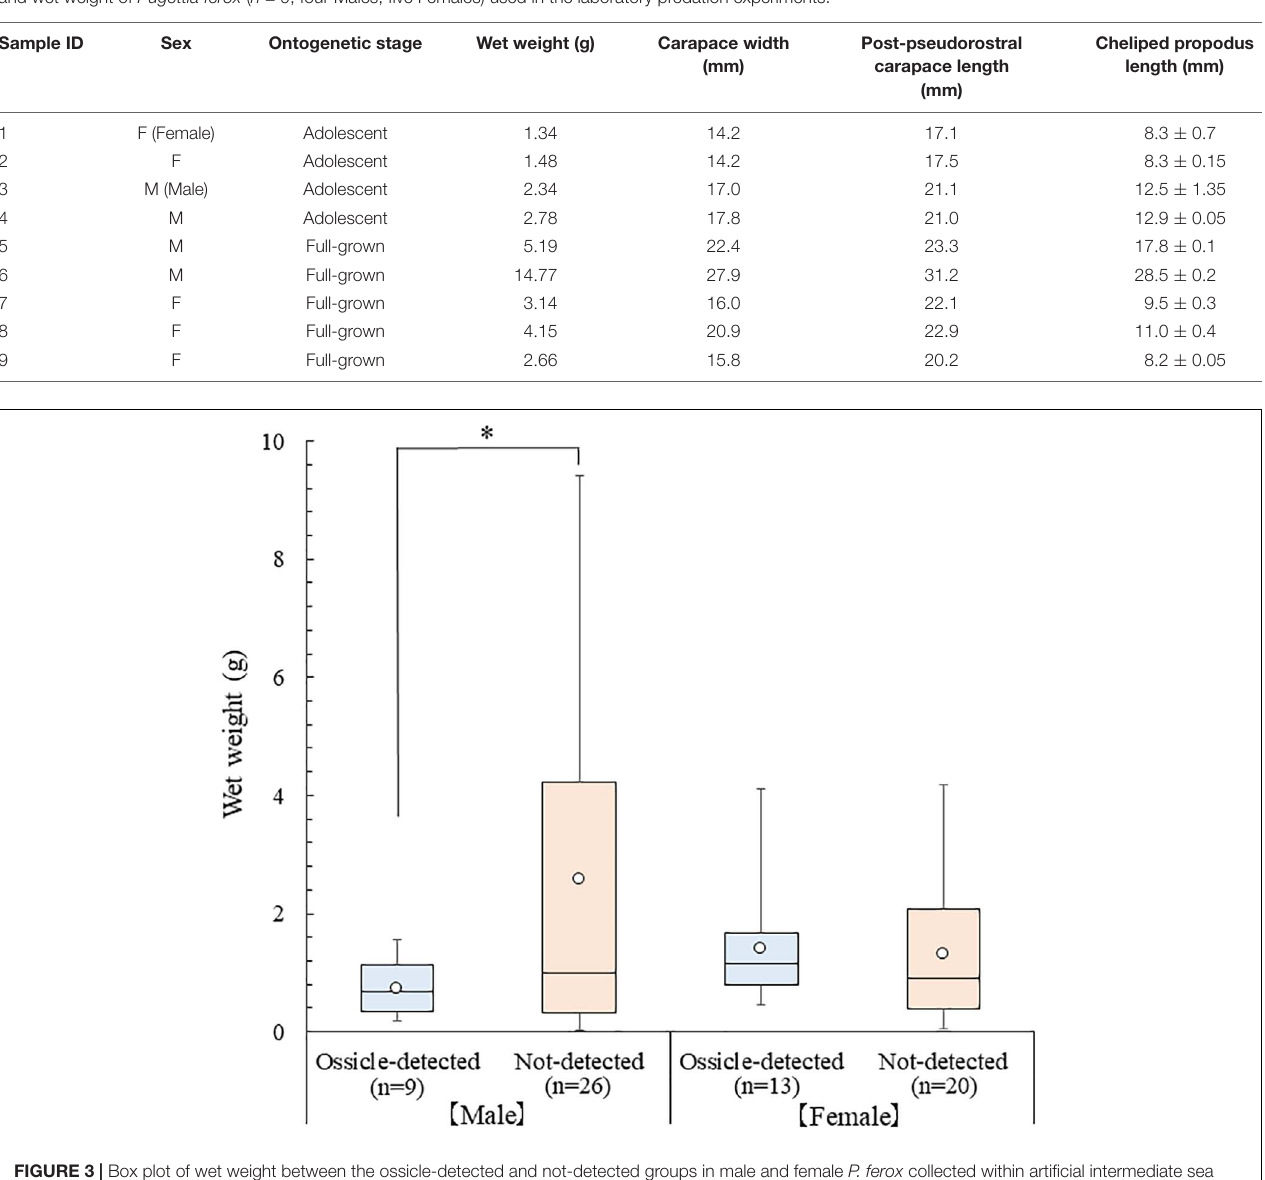
TABLE 1 | Measured carapace width at the widest part (CW), post-pseudorostral carapace length (PCL), an average of the right and left cheliped propodus length (CPL), and wet weight of Pugettia ferox ( n = 9, four Males, five Females) used in the laboratory predation experiments. Sample ID